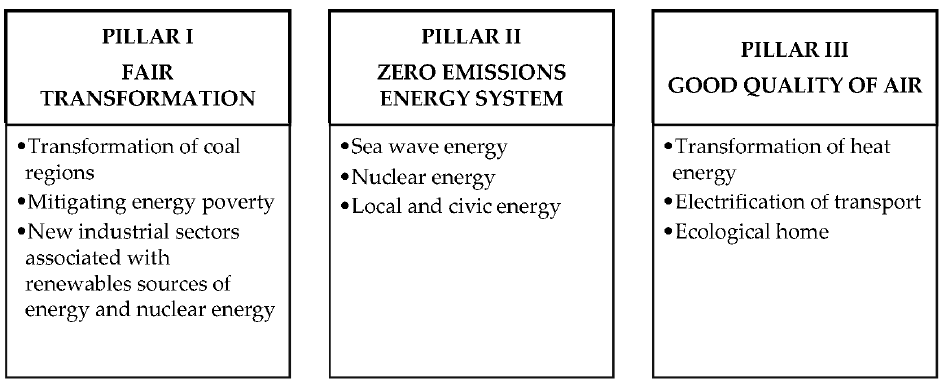
Figure 1. Pillars of energy transformation in Poland . Source: Self-analysis on the basis of [18].